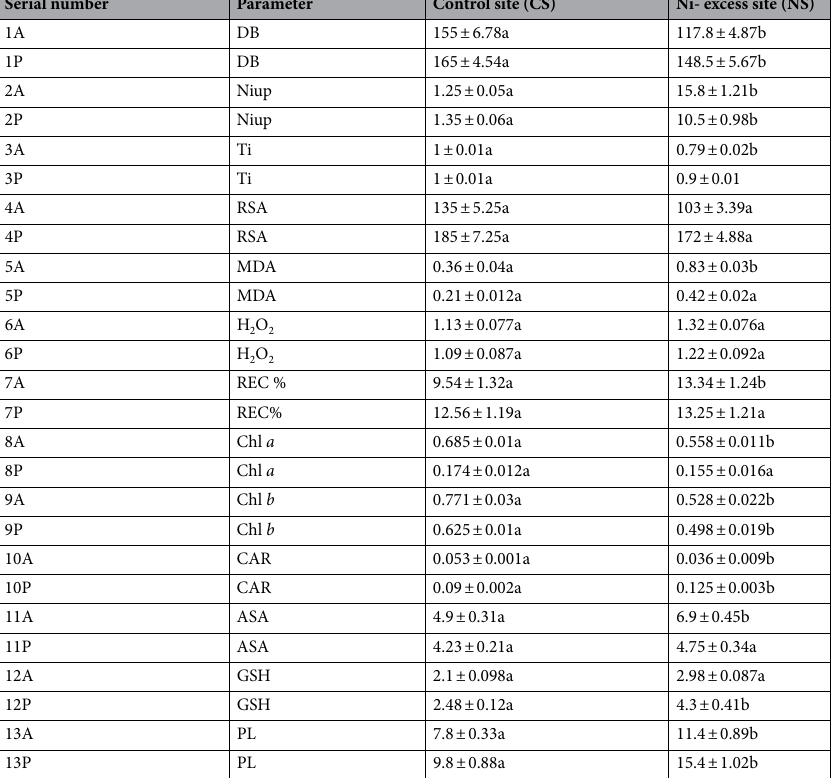
Table 3. Physiological indices of young gametophytic thalli of Asterella wallichiana and Plagiochasma appendiculatum . DB (mg kg -1 , dry weight), dry biomass ; Niup, nickel (Ni) uptake (mg kg -1 , dry weight); Ti, Ni tolerance index (Ti); RSA, rhizoid surface area; malondialdehye (MDA) and H 2 O 2 contents (µmol g -1 fresh weight); relative electrical conductance (REC %), chlorophyll a (Chl a ), chlorophyll b (Chl b ), carotenoid (CAR), ascorbic acid (ASA), glutathione (GSH) and proline (PL) contents (mg g -1 fresh weight) in young gametophytic thalli of A. wallichiana and P. appendiculatum grown in Ni-excess sites (NS, n = 5) and control sites (CS, n = 5) were measured. Different letters (a and b) within a row indicate significant differences from each other in all combinations (Tukey’s test, P ≤ 0.05). Bold letters A and P represent A. wallichiana and P. appendiculatum ,